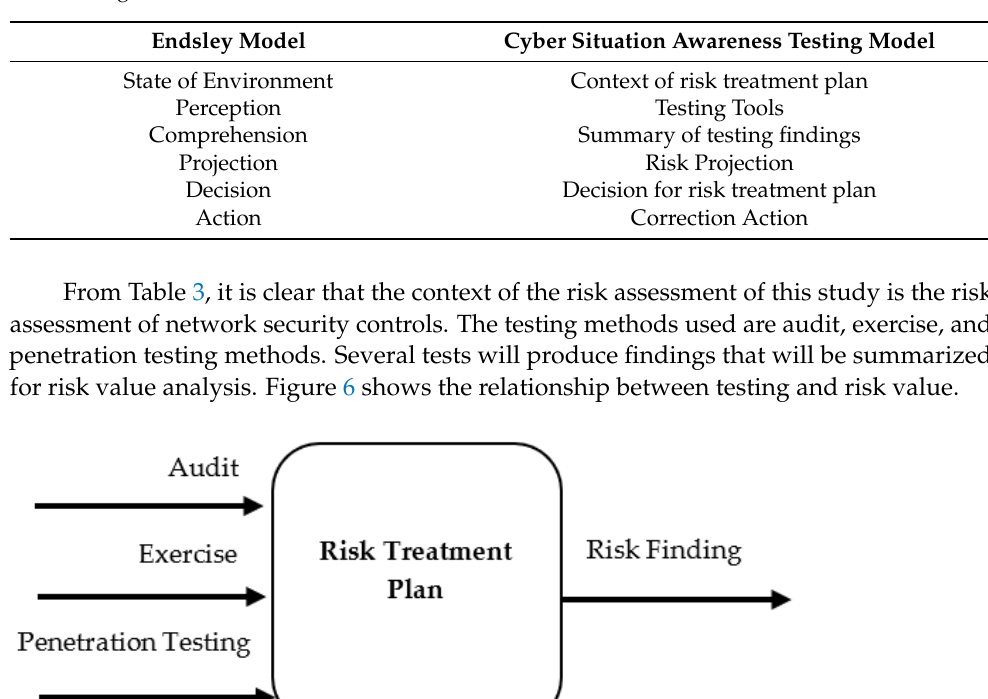
Table 3. Relationship Between the Elements of the Endsley Model and the Cyber Situational Aware- ness Testing Model.